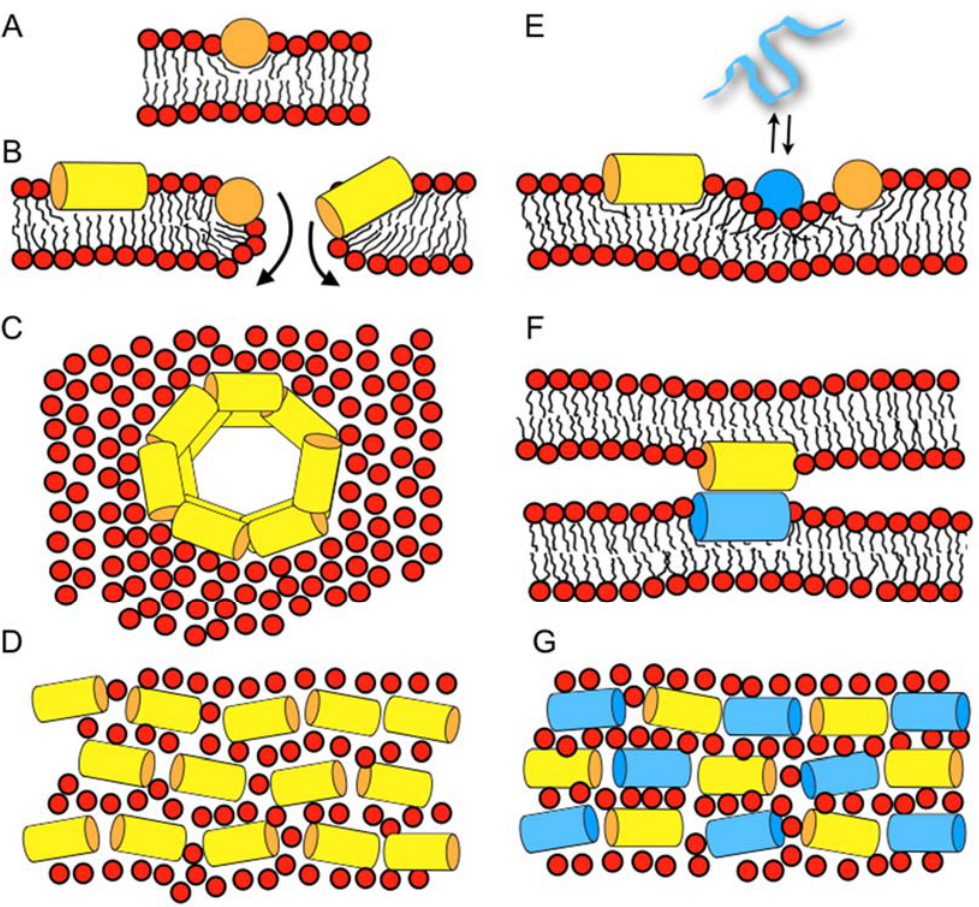
Figure 1. Schematic models illustrating how antimicrobial peptides work and interact with membranes ( A – D ), and how two peptides can interact synergistically in a membrane environment ( E – G ). ( A ) Peptides such as magainin partition into the membrane interface and cause disordering of the lipid packing. ( B ) Bilayer openings form stochastically when the peptide concentration increases locally, or when the membrane disrupts at high peptide ‐ to ‐ lipid ratios [72]. Along the openings, the peptides can insert and cross in in ‐ planar or at tilted alignments. ( C ) In molecular dynamics calculations schematic, amphipathic helices have been simulated to form double belts [73], an arrangement which also agrees with the in ‐ planar alignment of the peptide helices observed by solid ‐ state nuclear magnetic resonance NMR spectroscopy [38]. ( D ) Fluorescence quenching experiments suggest mesophase structures formed by in ‐ plane oriented helices [74]. ( E ) The membrane disruptive properties of one peptide (yellow) help the insertion of another one (blue), which by itself is less likely to partition into membranes of high negative curvature [75]. ( F ) Peptide ‐ peptide contacts result in the agglutination of liposomes (Figure 3) [76], and could be responsible for synergistic enhancement of activities. ( G ) A more densely packed mesophase arrangement forms in the presence of two peptides with complementary charge distribution such as magainin 2 and PGLa [77]. Notably, multiple mechanisms, such as a combination of E , F, and G may apply. Panels A , B , E, and F show side views, panels C , D, and G show top views of the lipid bilayer.